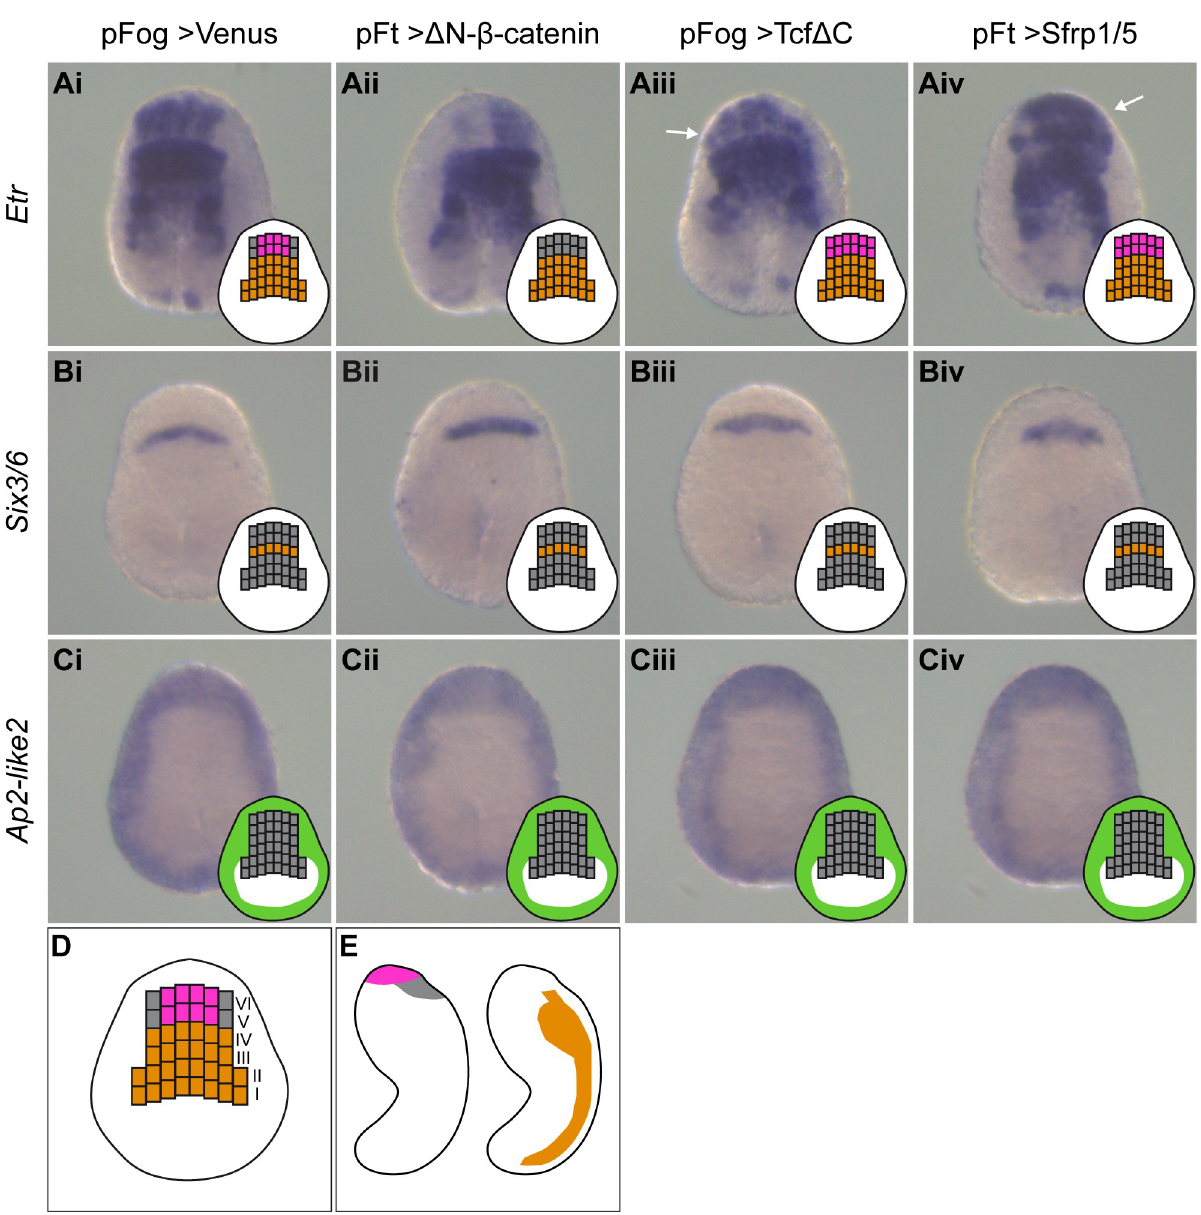
Fig 6. Regulation of anterior neural plate border patterning by Wnt signaling. (A-C) Embryos were electroporated with pFog > Venus (i), pFt > Δ N- β -catenin (ii), pFog > Tcf Δ C (iii), or pFt > Sfrp1/5 (iv), and fixed for in situ hybridization at early neurula stages (stages 13/14) for Etr (A), Six3/6 (B) and Ap2-like2 (C). Ectopic expression in the lateral anterior neural plate border is indicated by the white arrows. For each embryo, a schematic in the bottom right corner depicts the neural plate (rows I to IV) and the anterior neural plate border (rows V and VI) in grey, and gene expression according to tissue: PNS (pink), epidermis (green) and CNS (orange). The eight median cells expressing Etr in rows V and VI are the palp region precursors. Gene expression change is unilateral in Aii, Aiii and Aiv because of the mosaic inheritance of the electroporated plasmid. Embryos are in dorsal (neural plate) view with anterior to the top. (D-E) Schematic representation of the progeny of neural plate blastomeres (D) at tailbud stages (E): palp precursors in pink, aATENS precursors in grey and CNS precursors in orange (adapted from [52,69]). Dorsal view with anterior to the top in D, and lateral view with anterior to the top and ventral to the left in E. Number of experiments: one for Six3/6 ; two for Etr and Ap2-like2 . for cWnt signaling in patterning the AP axis during early embryonic development, at least at the base of the deuterostomes [22]. In particular, the ascidian epidermis that contains neuro- genic domains (forming ESNs) is highly regionalized along the AP axis. While we are not